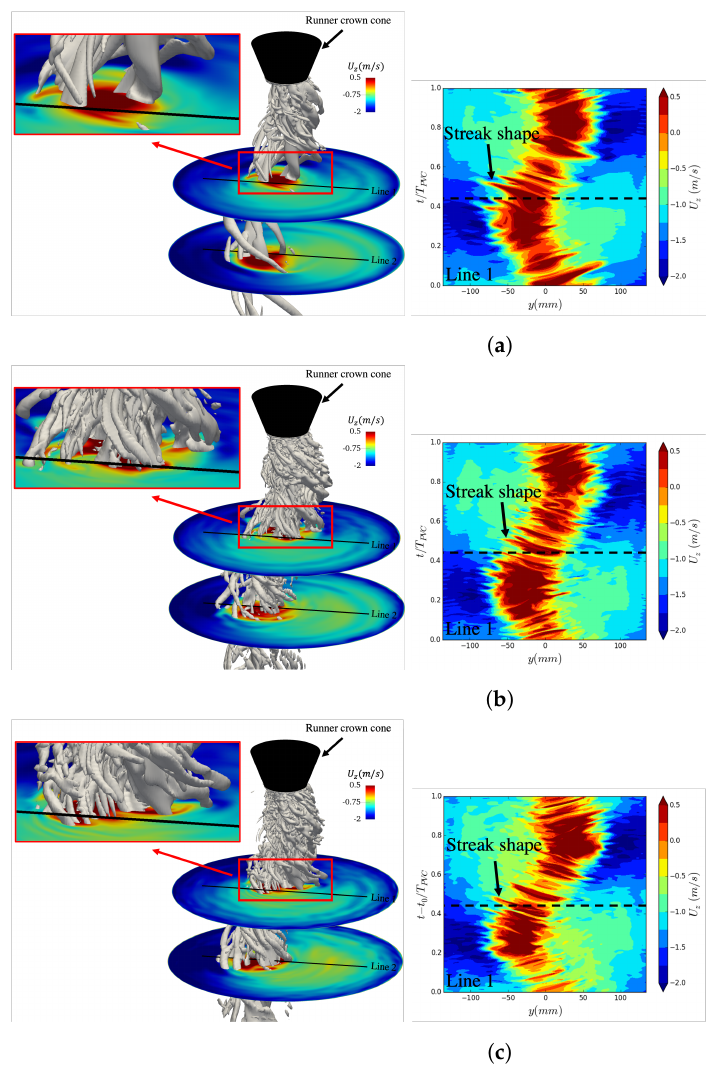
Figure 4. RVR (left figures) and its effect on the axial velocity at Line 1 during one RVR cycle (right figures), ( a ) SAS, ( b ) zonal WMLES, ( c ) WMLES. The vortices are shown by the iso-surface Q = 5000 s − 2